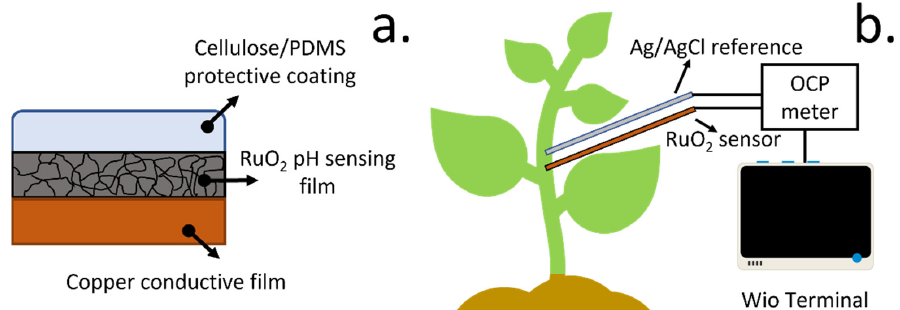
Figure 1. ( a ) Schematic representation of final sensor structure, comprising a copper electrode, where the RuO x films were fabricated by electrodeposition for the sensing of pH, and a cellulose/PDMS coating was applied by aerosol deposition as a protective film, to improve stability. ( b ) After the fabrication of the sensors, the electrodes were implanted inside 4-week tomato plants. Both a solid- state Ag/AgCl reference and RuO x films were incorporated, and the OCP was measured using a Wio Terminal device.